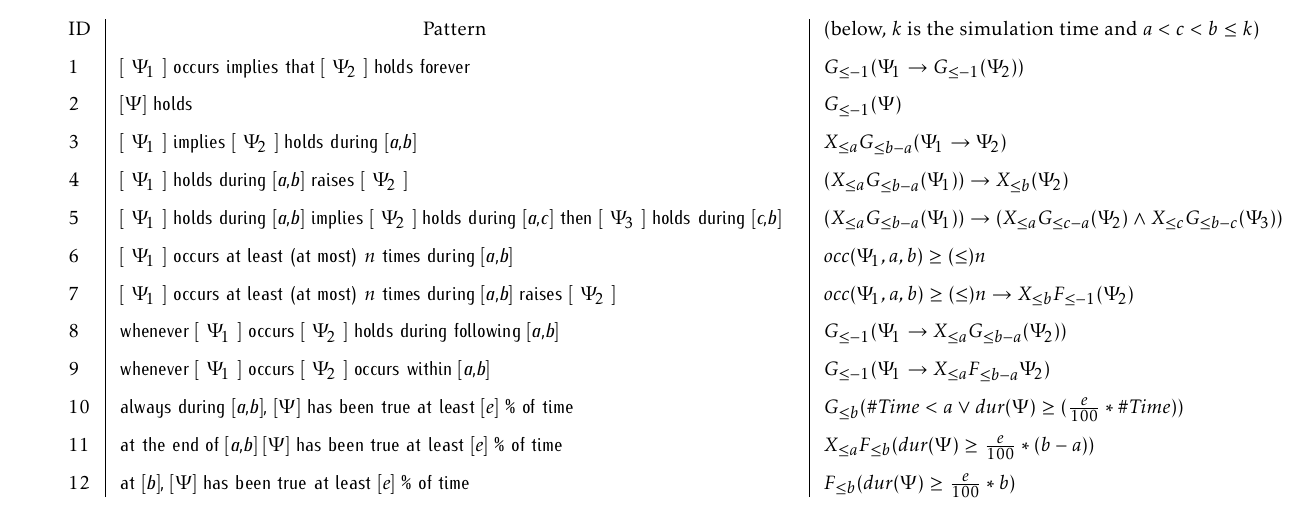
Figure 1. GCSL Patterns and their BLTL translations, with Ψ , Ψ